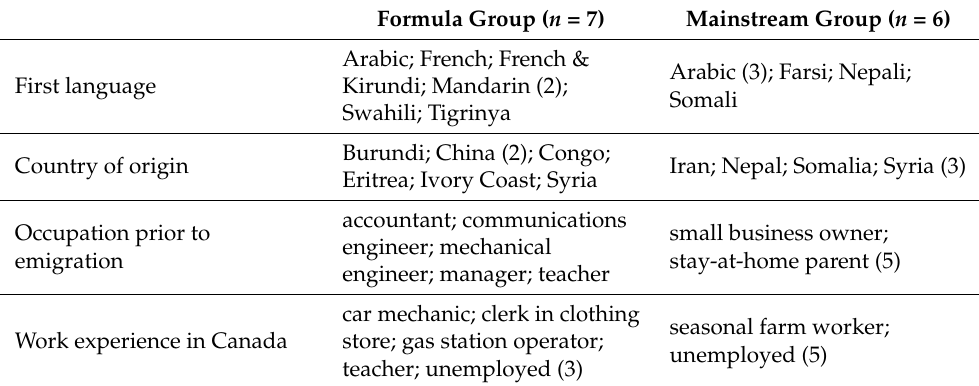
Table 1. Characteristics of the participants in the study by Zavialova